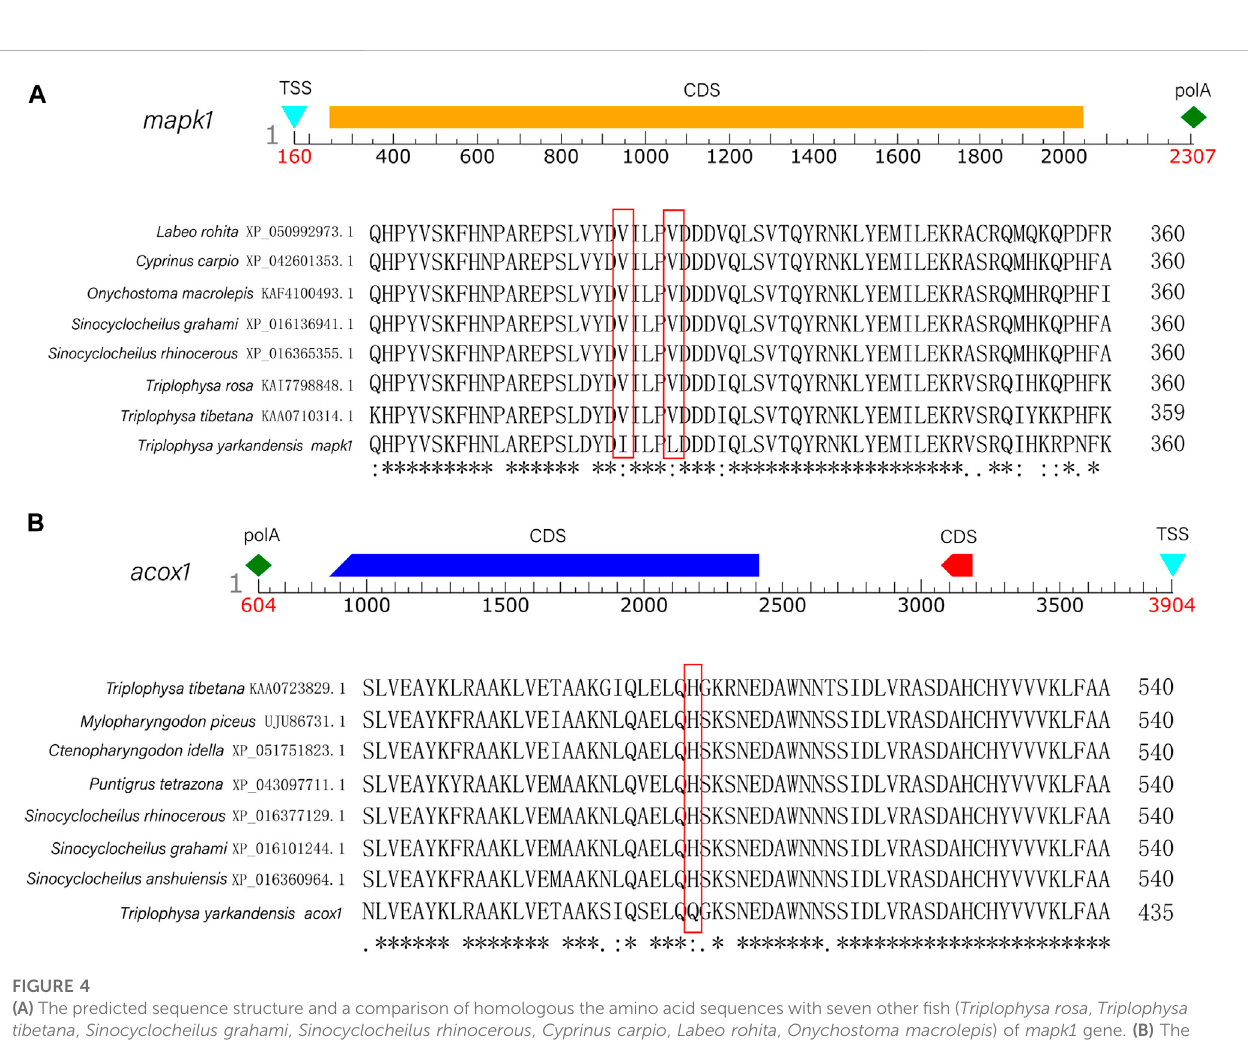
predicted sequence structure and a comparison of homologous the amino acid sequences with seven other fi sh ( Triplophysa tibetana , Mylopharyngodon piceus , Ctenopharyngodonidella , Puntigrustetrazona , Sinocyclocheilusrhinocerous , Sinocyclocheilusgrahami , Sinocyclocheilusanshuiensis )of acox1 gene.